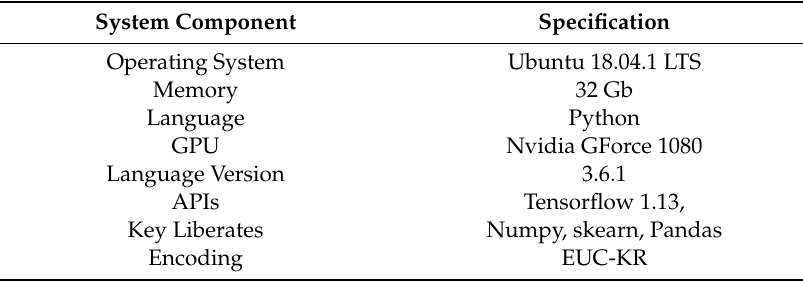
Table 2. System’s components and